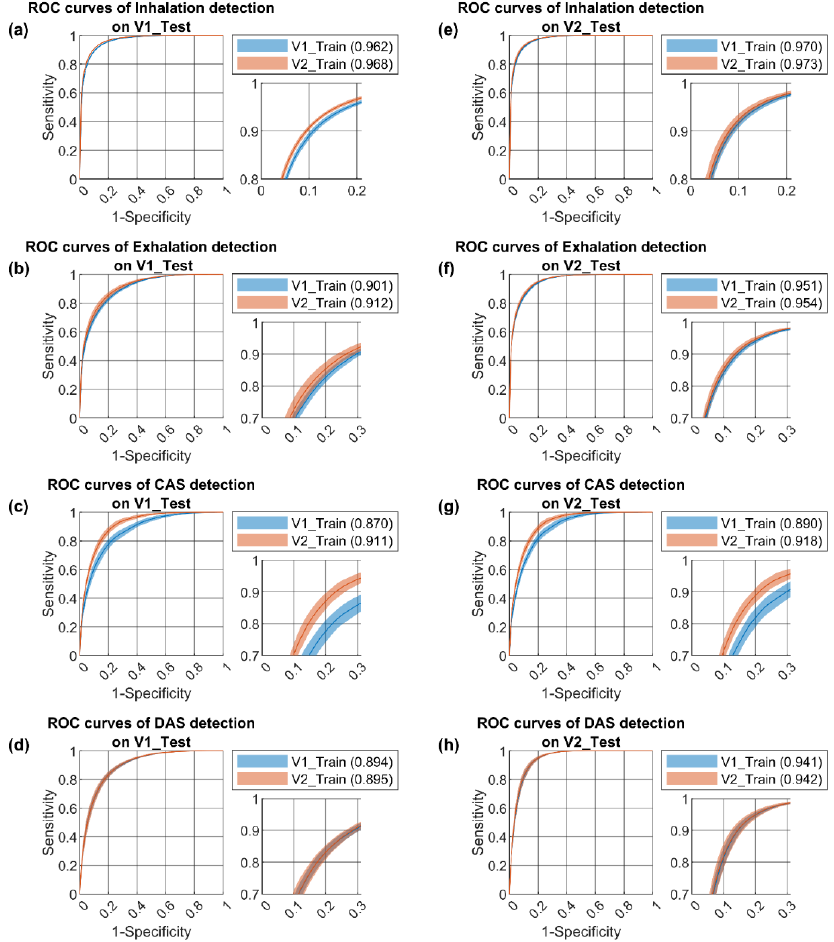
Figure 6. ROC curves of the V1_Train-based and V2_Train-based models tested using V1_Test for ( a ) inhalation, ( b ) exhalation, ( c ) CAS, and ( d ) DAS segment detection and using V2_Test for ( e ) inhalation, ( f ) exhalation, ( g ) CAS, and ( h ) DAS segment detection. Solid lines represent the ROC curves, and the colored shades represent areas between the 95% confidence intervals. The blue lines and blue shades stand for the models trained using V1_Train, and the red lines and red shades stand for the models trained using V2_Train. The values in the parentheses in the legends indicate the mean